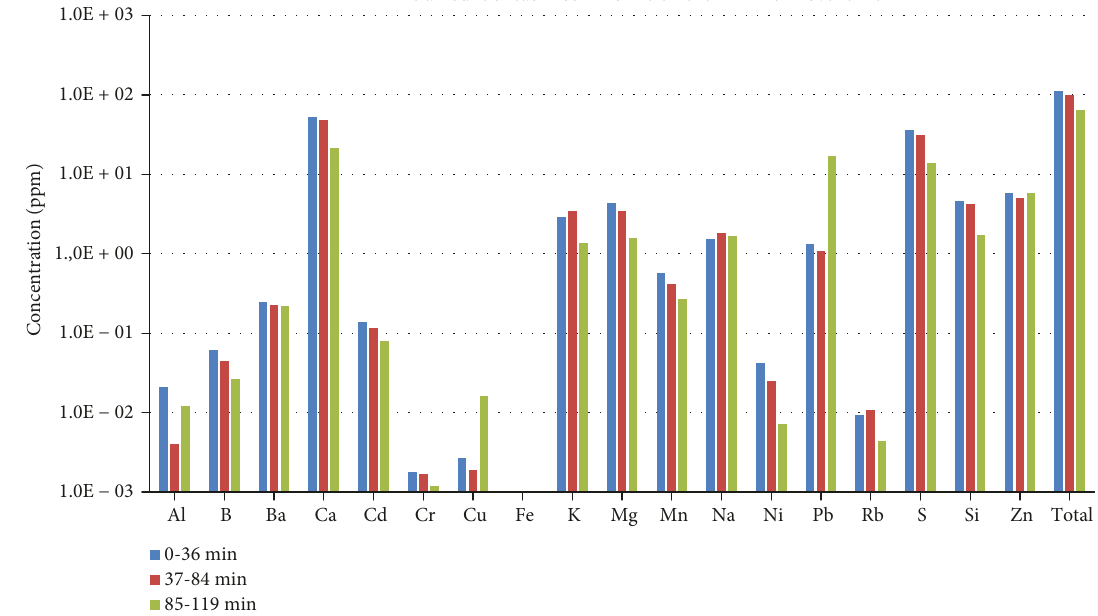
Figure 20: The kinetics of elemental composition over time in leachates from HTL322 sample reacted with deionised water at 200 ° C temperature under 250bar pressure in the fl ow-through reactor after 36, 84, and 119 minutes,